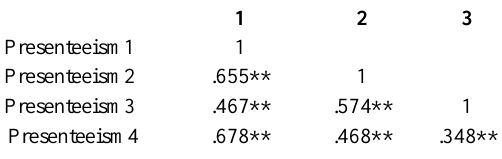
Table 6: Correlations among Different Measures of